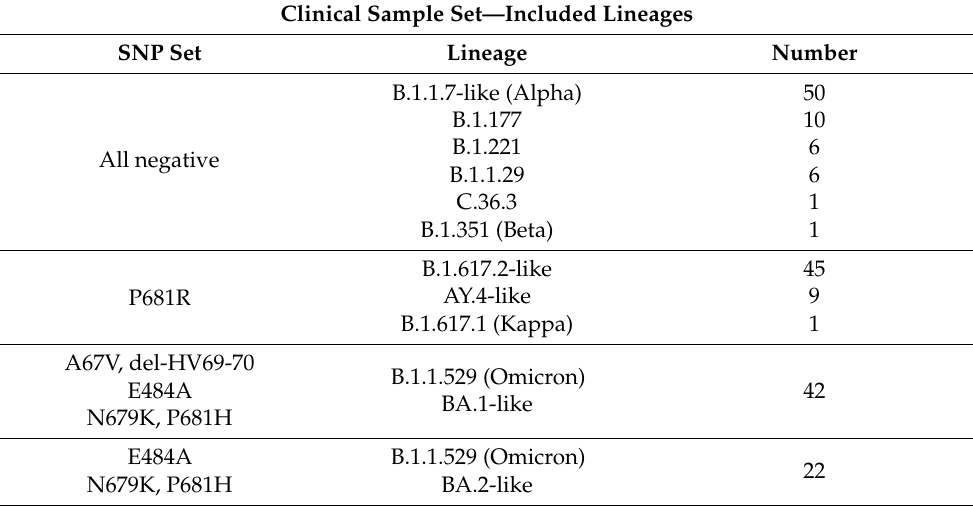
Table 5. Lineages included in the clinical sample set, as determined by whole genome sequencing. Clinical Sample Set—Included